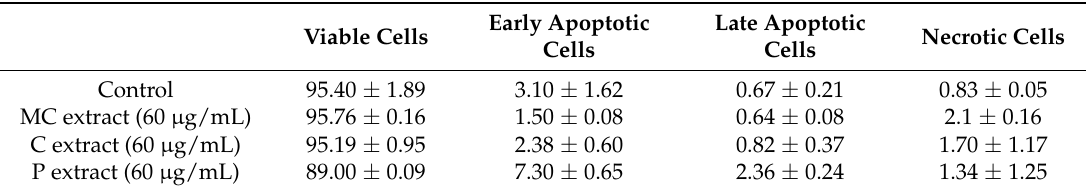
Table 6. Apoptotic events for A375 human melanoma cell line after incubation with selected extracts.